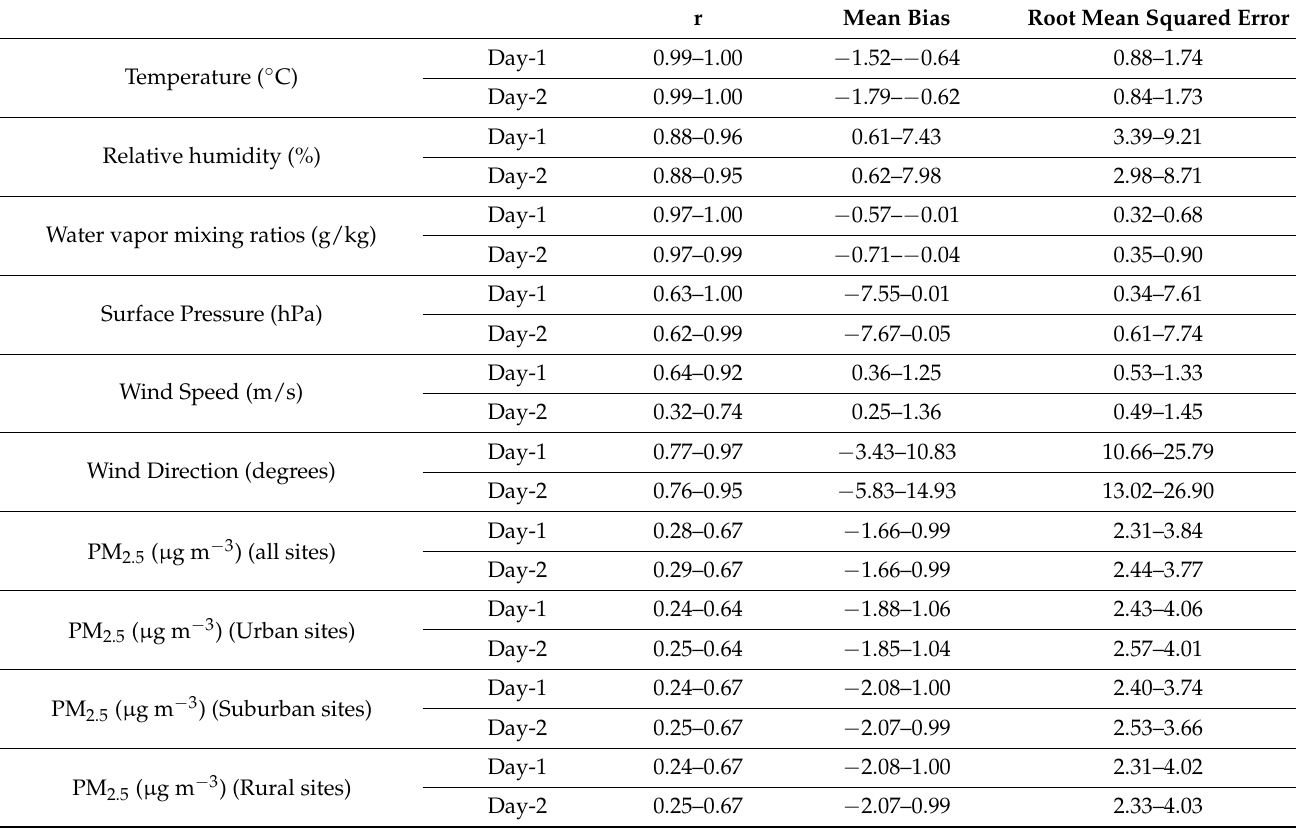
Table 2. Comparison of the range of statistical parameters for the first- and second-day forecasts from 1 June 2019 to 31 May